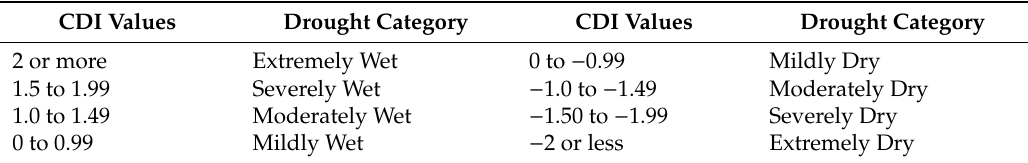
Table 3. IMD derived drought categories and